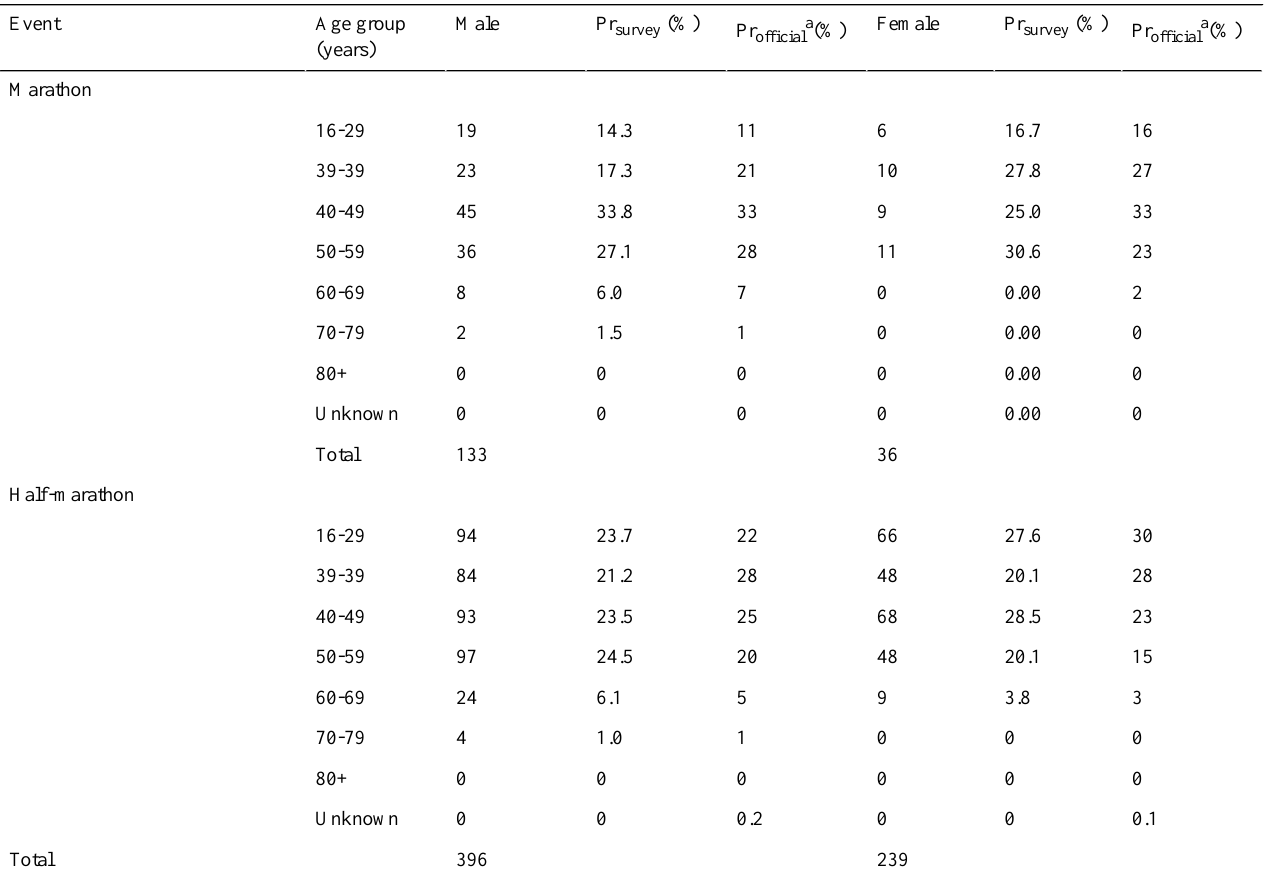
Table 1. Distribution of sex and age groups among runners for the full and half-marathon (Q 1